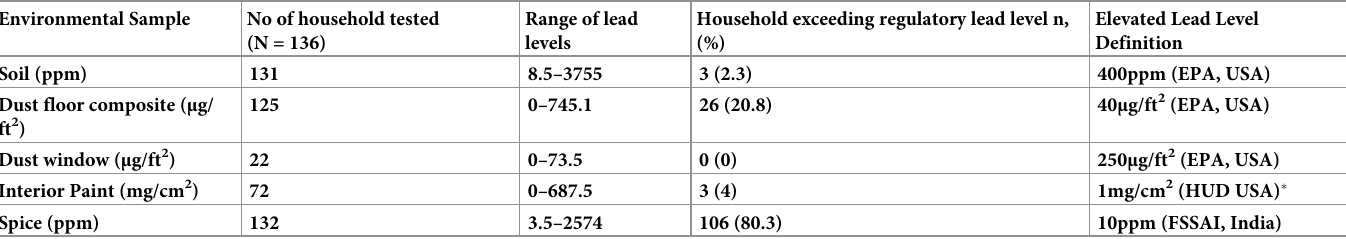
Table 6. Comparison of lead levels in environmental samples with regulatory standards, Patna, Bihar, February 2020. Environmental Sample